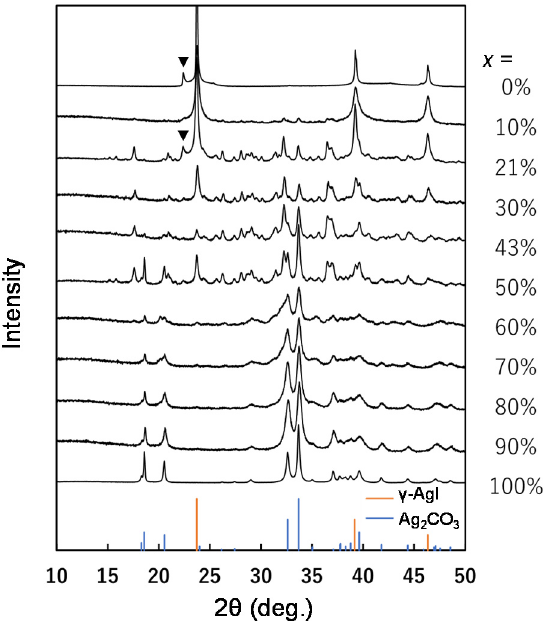
Figure 1. XRD patterns of the unheated x Ag 2 CO 3 –(1 − x ) AgI samples after mixing—the peaks indicated using ▼ correspond to β -AgI (ICDD # 9–374); the line diagrams at the bottom indicate the peak positions of γ -AgI (orange) and Ag 2 CO 3 (blue).